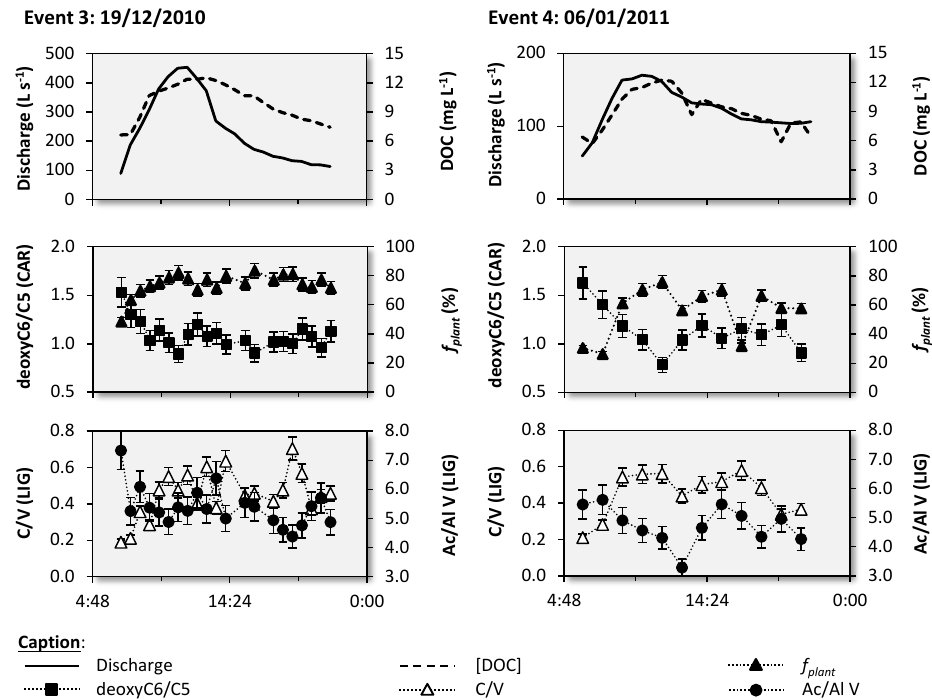
Figure 4. Temporal change in flow and DOC concentration and composition during storm events 3 and 4. Various units indicated in the axis labels. The uncertainties for deoxyC6 / C5, f plant , C / V and Ac / Al (V) are the mean RSDs calculated for five samples analyzed in triplicate.